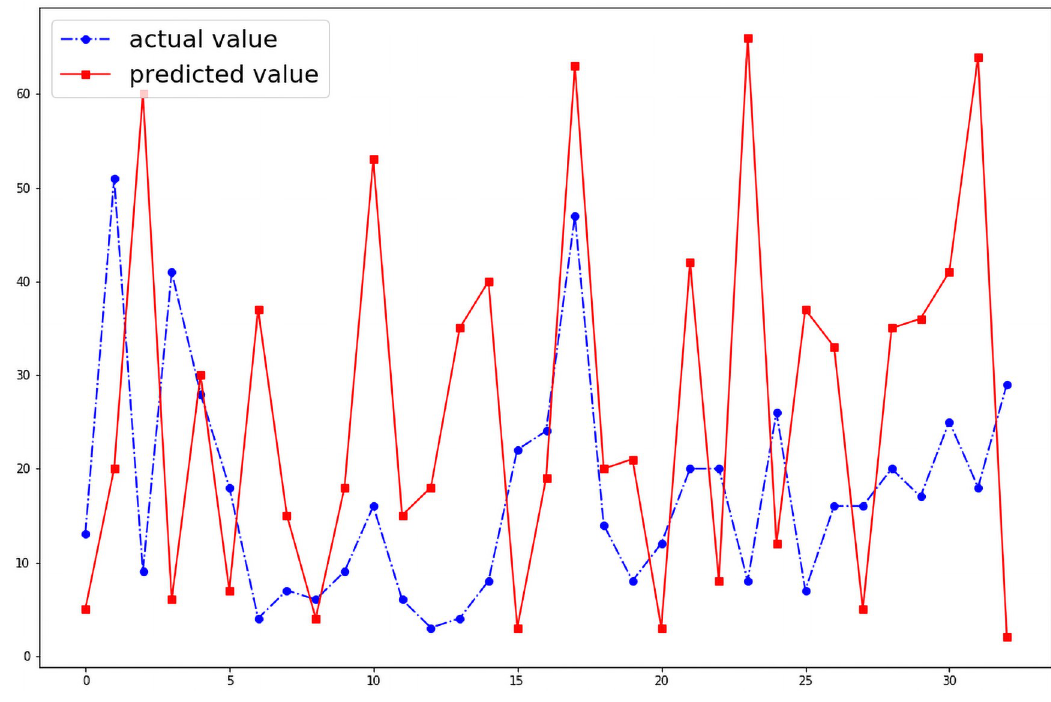
Fig 4. Without optimization (RMSE: 25.45).